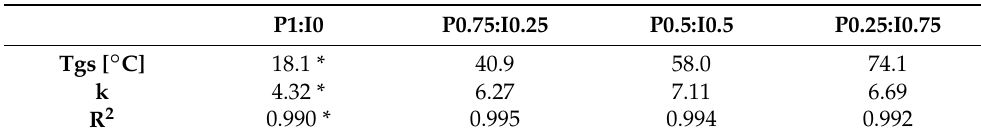
Table 2. Parameters of the Gordon–Taylor equation fitted to experimental data of the pumpkin–inulin